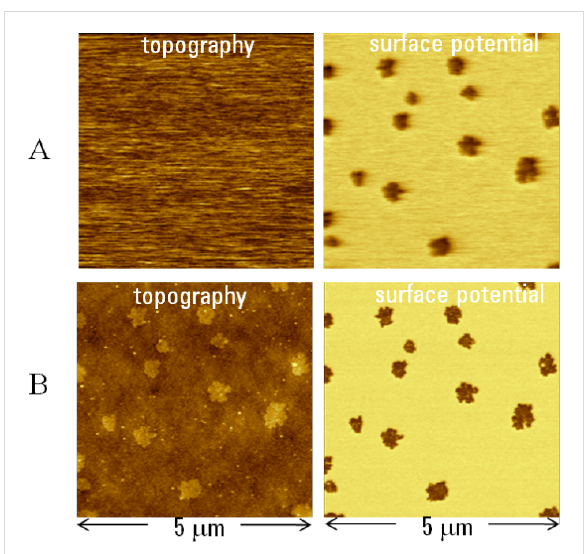
Figure 3: Topography and surface potential images of F 14 H 20 self- assemblies on Si substrate. The images in A were obtained in the non- contact regime with A sp just above the transition level from the non- contact to the intermittent contact regime (see Figure 2A). The images in B were recorded in the intermittent contact regime with A sp below the transition level. The contrast covers height variations in the 0–10 nm range in the topography images and potential changes in the 0–1 V range in the surface potential images. The averaged surface potential difference between the self-assemblies and the substrate is 0.75 V for the image in A and 0.79 V for the image in B